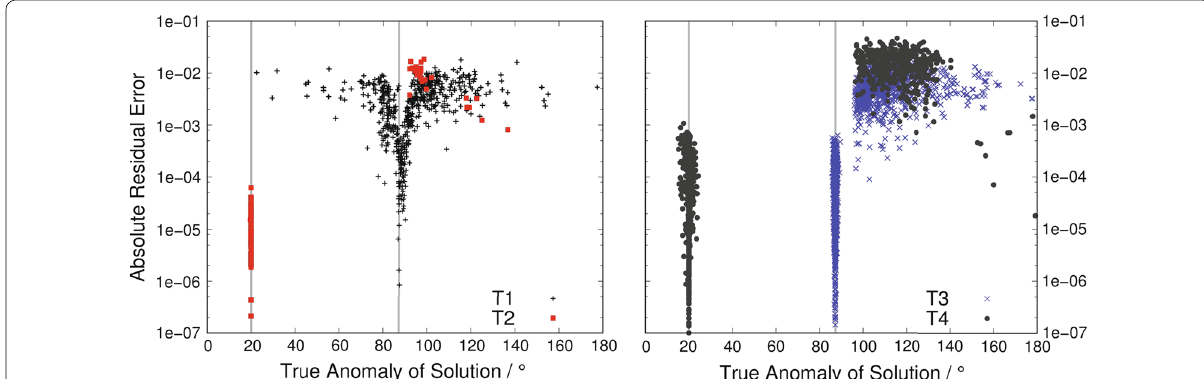
Fig. 2 Solution of the Gaussian VoP method to four simulated satellite fragmentations. The grey lines indicate the true location of each